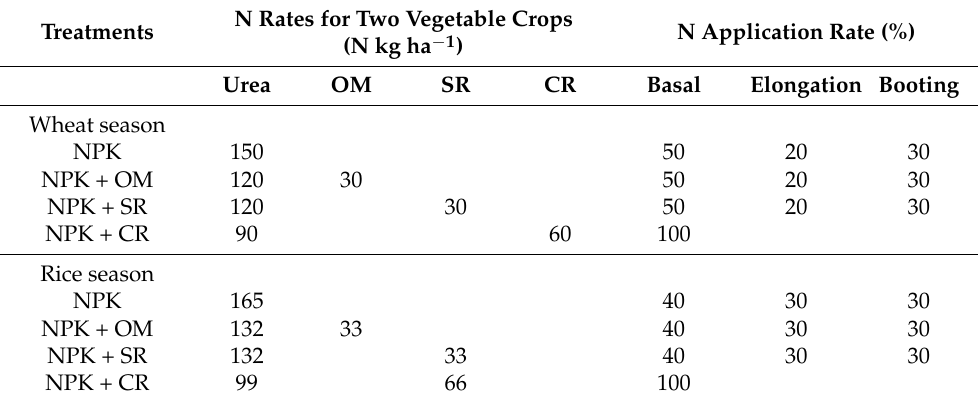
Table 1. Fertilizer application and filed operation during different periods of wheat-rice rotation. N Rates for Two Vegetable Crops Treatments N Application Rate (%) (N kg ha − 1 ) Urea OM SR CR Basal Elongation Booting Wheat season NPK 150 50 NPK + OM 120 NPK + SR 120 NPK + CR 90 100 Rice season NPK